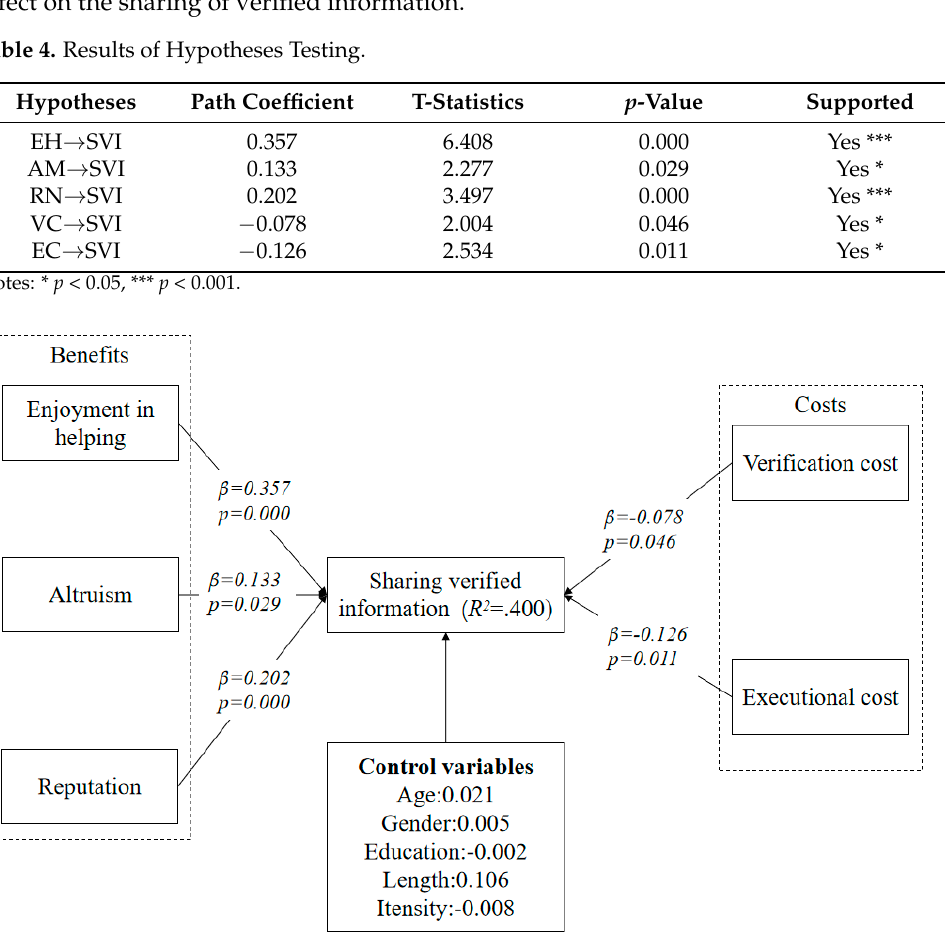
Table 4. Results of Hypotheses Testing.